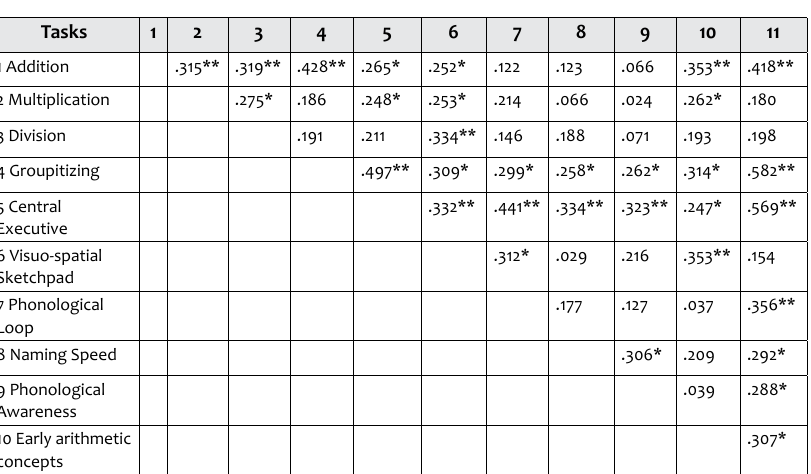
Table 3: Correlations among approximate arithmetic, working memory and other cognitive measures assessed in Study